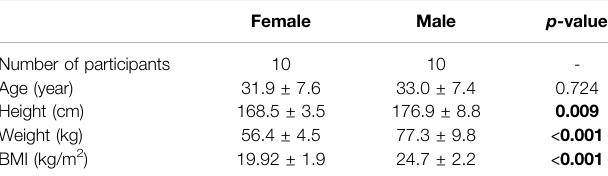
TABLE 1 | Demographic data (mean ± standard deviation) of the participants. Bold values show that males have a signi fi cantly greater body height, weight, and body mass index (BMI) ( p < 0.05) than females.